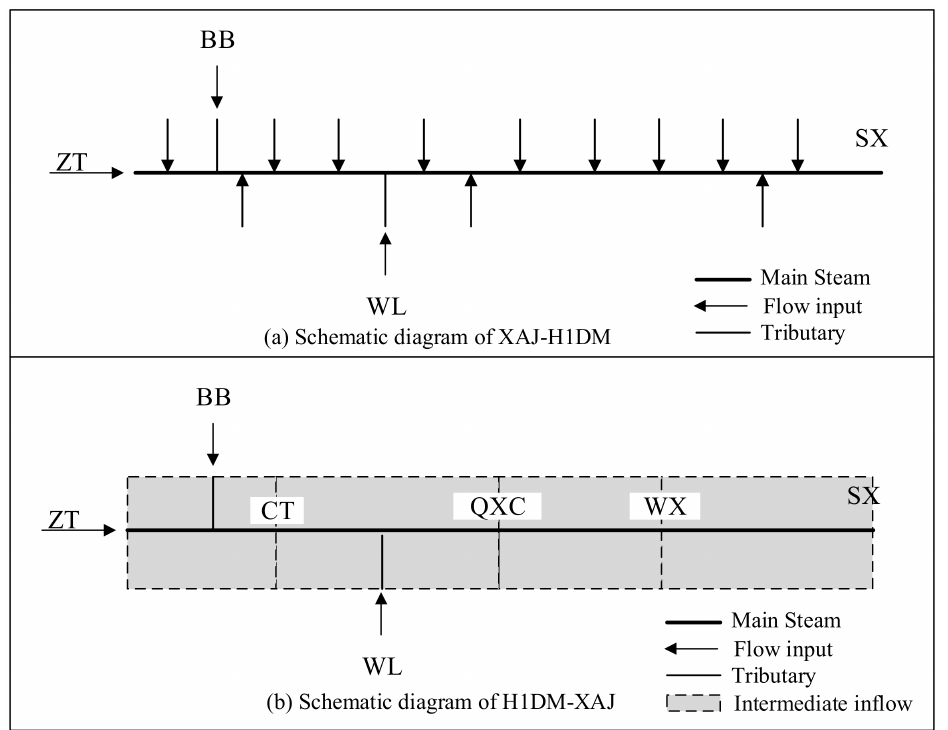
Figure 4. Schematic diagram of XAJ-H1DM ( a ) and H1DM-XAJ ( b